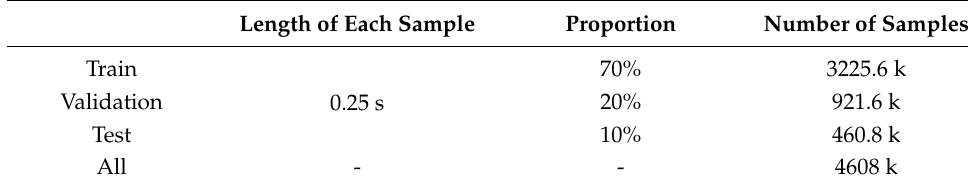
Table 2. Detailed description of the custom